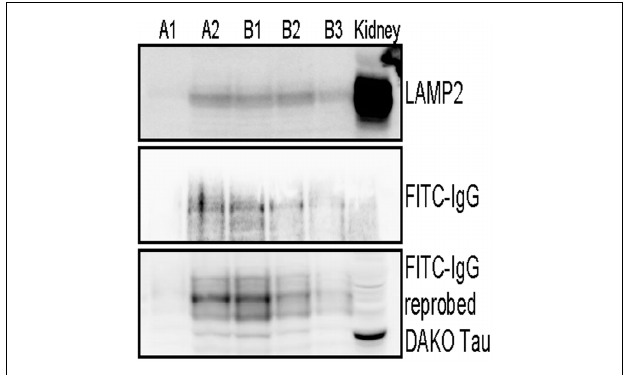
FIGURE 3 | FITC labeled IgG from a high titer mouse and tau are present in enriched lysosome fractions. Immunoblotting analysis of enriched lysosome fractions from two separate JNPL3 mice brain preparations is shown, A and B respectively. Brain slices (400 μ m) were incubated with FITC–IgG from a high titerTau 379–408[pSer 396,404 ] immunized mouse for 2h. Post treatment slices were processed to obtain an enriched lysosome fraction. Several fractions were obtained and the presence of lysosomes was confirmed in LAMP2 positive fractions A2, B1, B2, and B3. Mouse kidney lysate was used as a positive control.The kidney control is not a purified kidney preparation but a whole organ lysate, hence it has more background staining when compared to the enriched lysosome fractions from brain. Lysosome fractions were also immunoblotted for FITC–IgG. Fractions A2, B1, B2, and B3 were positive for FITC–IgG.To test if the lysosome fractions also contained tau, the FITC–IgG blot was reprobed with an antibody to total tau (DAKO A0024). Lysosome fractions A2, B1, B2, B3, and kidney lysate, all were positive for tau. Importantly, most of the FITC–IgG was detected in fractions with the highest levels of tau (A2 and B1). Overall, these findings are in accordance with the histological